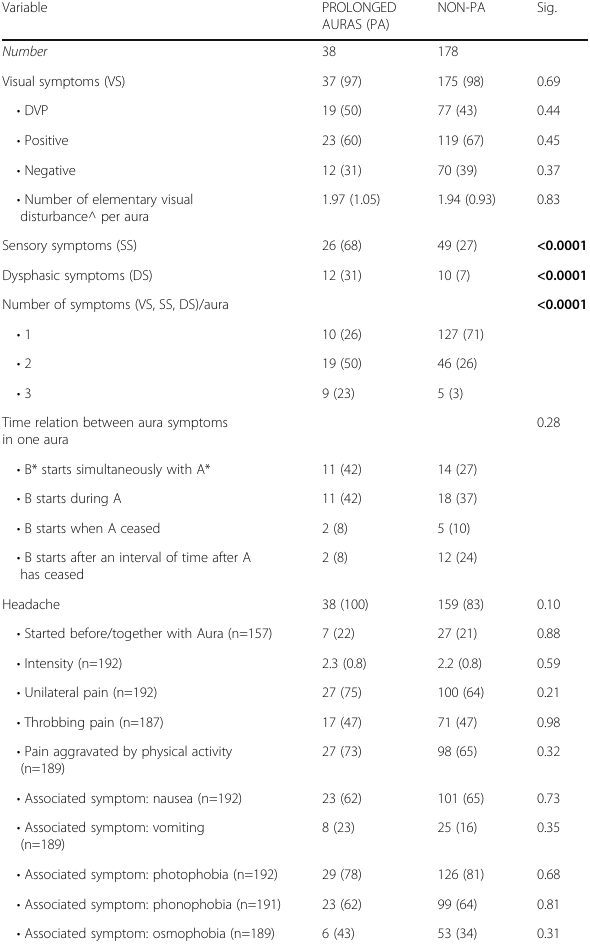
Table 1 (abstract O6). Characteristics of PA (auras with at least 1 symptoms lasting >1 h) and NON-PA